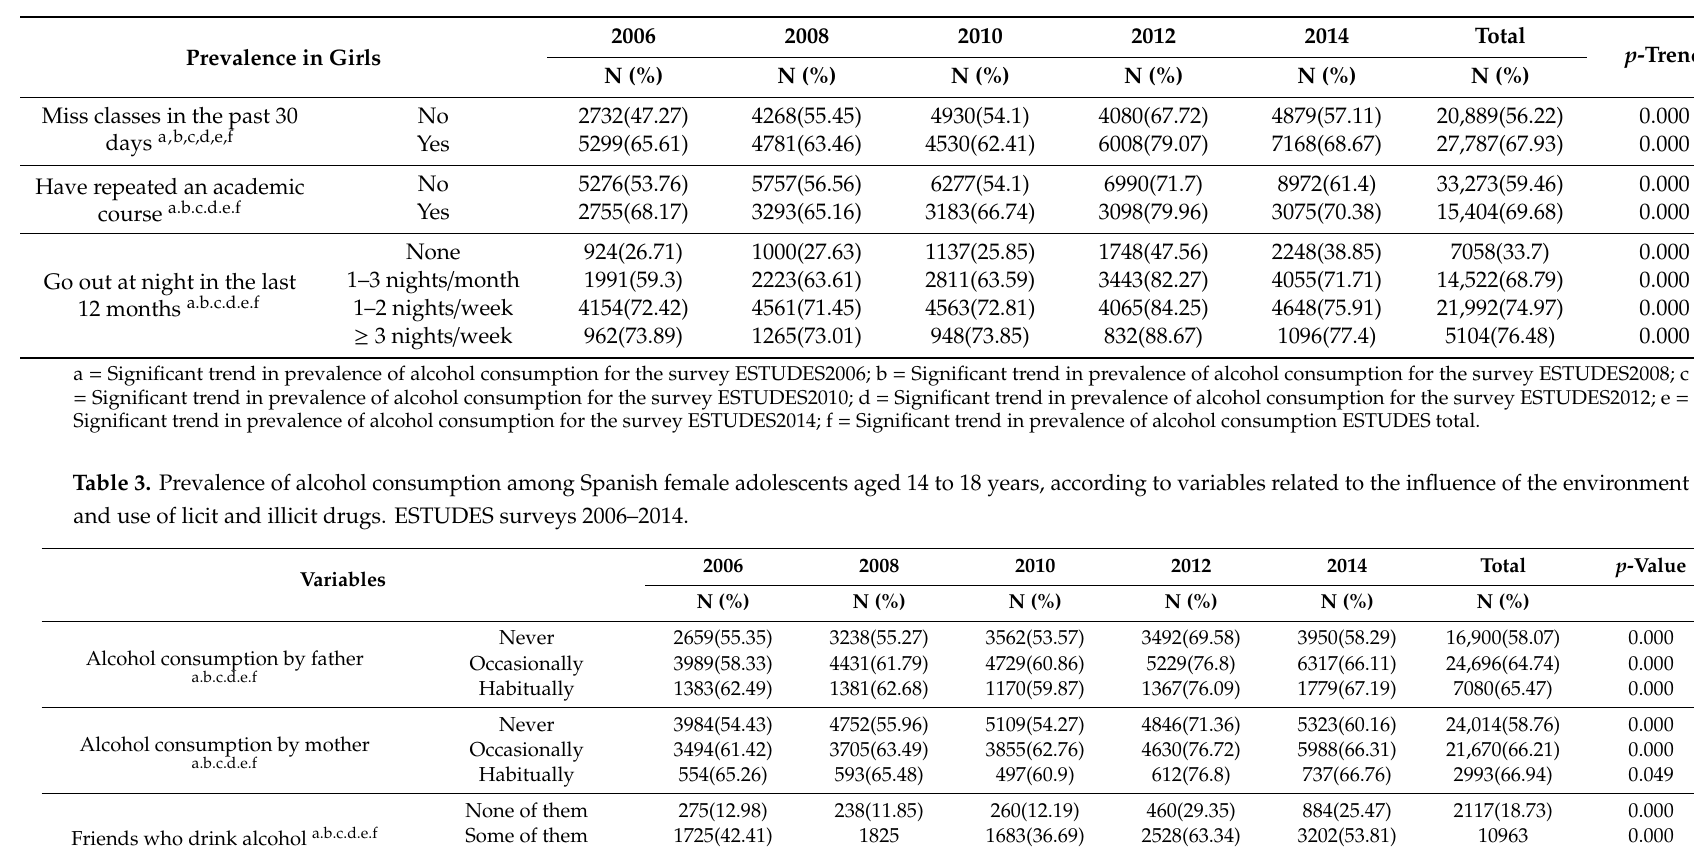
Table 2. Prevalence of alcohol consumption among Spanish female adolescents aged 14 to 18 years in Spain, according to variables related to study and free time. ESTUDES surveys 2006–2014.